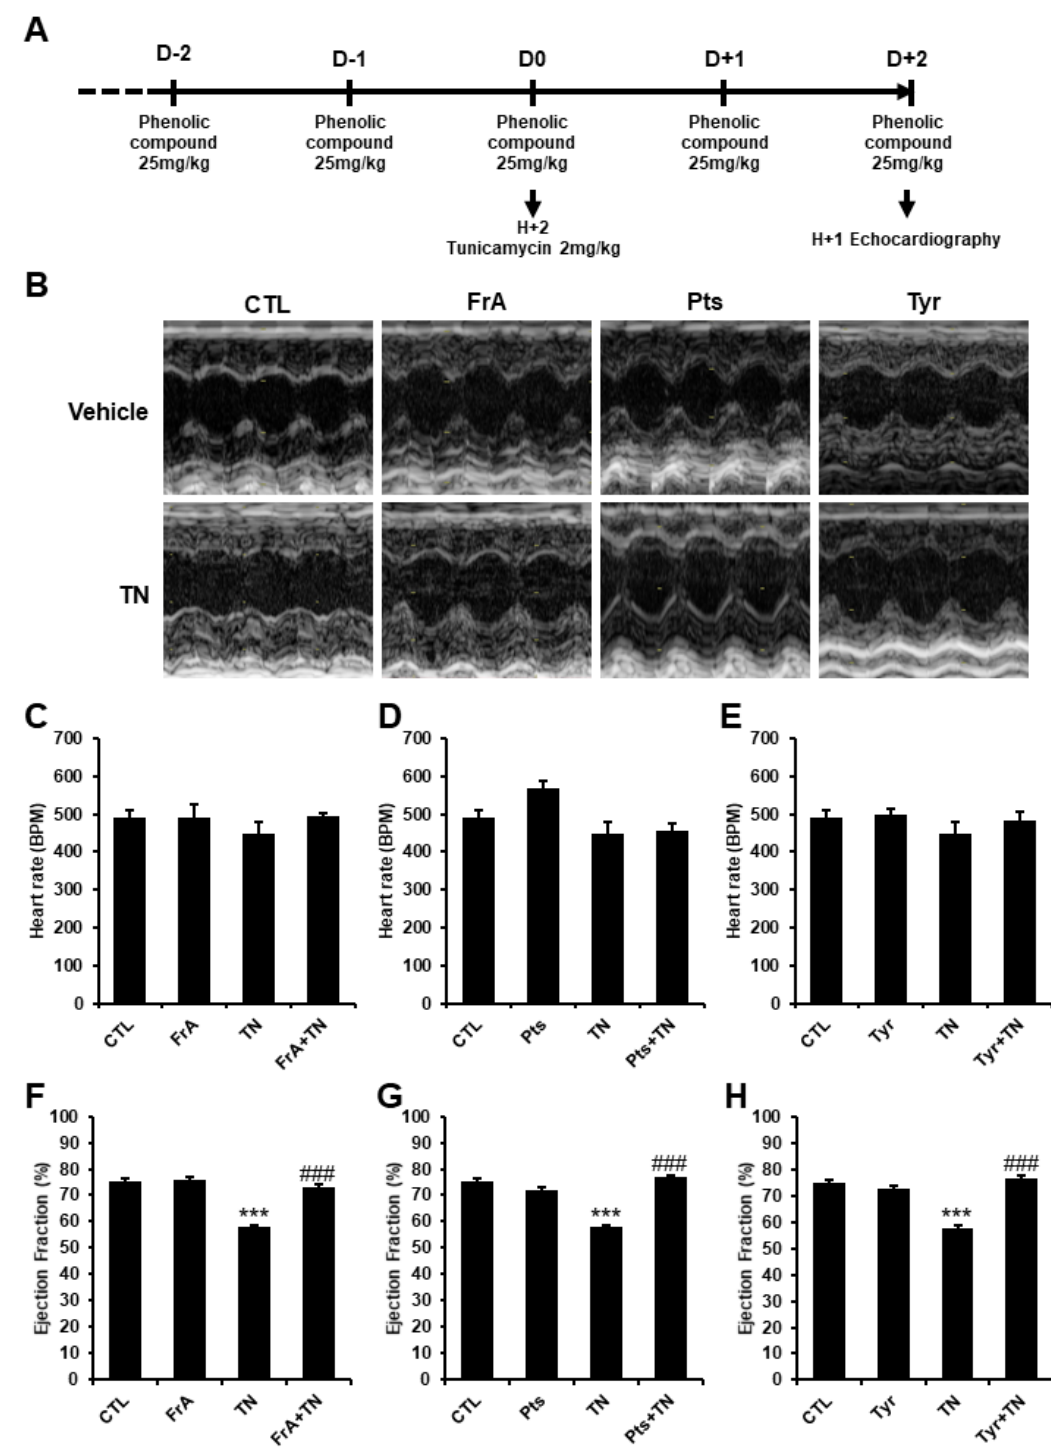
Figure 4. Ferulic acid, pterostilbene, and tyrosol protect the heart from ER-stress-induced dysfunction. Male C57BL/6J mice (12 weeks old) were injected i.p. every day for 5 days with the vehicle or 25 mg/kg of ferulic acid (FrA, C , F ), pterostilbene (Pts, D , G ), or tyrosol (Tyr, E , H ). At day 3, 1 h after phytochemical injection, mice were given 2 mg/kg tunicamycin (TN) by intraperitoneal injection to induce ER stress. Cardiac function was analyzed 48 h after TN injection by echocardiography ( A ). Representative images obtained by transthoracic echocardiography ( B ). Heart rate ( C – E ) and ejection fraction ( F – H ) are presented. Values represent mean ± S.E.M. ( n = 5) *** p < 0.001 vs. CTL; ### p < 0.001 vs.